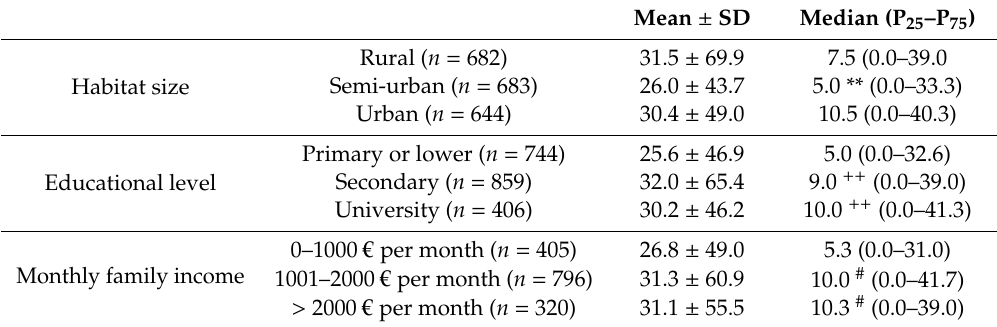
Table 6. Plate waste (PW, g / day) segmented by socioeconomic factors from the ANIBES study population.